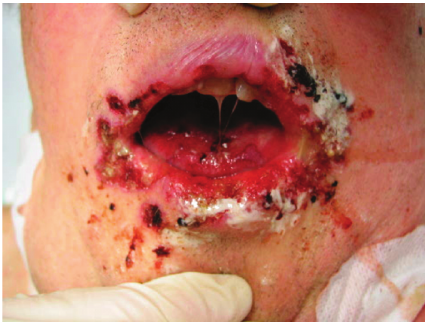
Figure 2: Autopsy revealed a massive retroperitoneal lymphoma. Giant retroperitoneal lymphoma masses enclosing abdominal aorta [ § ], inferior vena cava [#] and leading to stenosis of the right ureter [ ∗ ]. Tissue was formalin